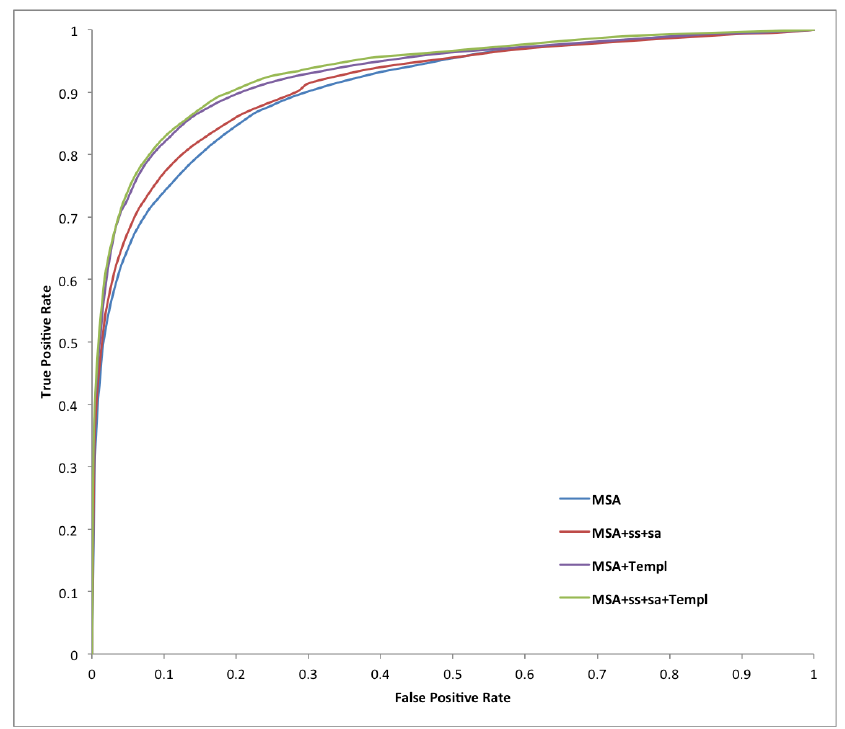
Figure 1. Receiver-operating characteristic curves for all of our systems on X-ray test set data.